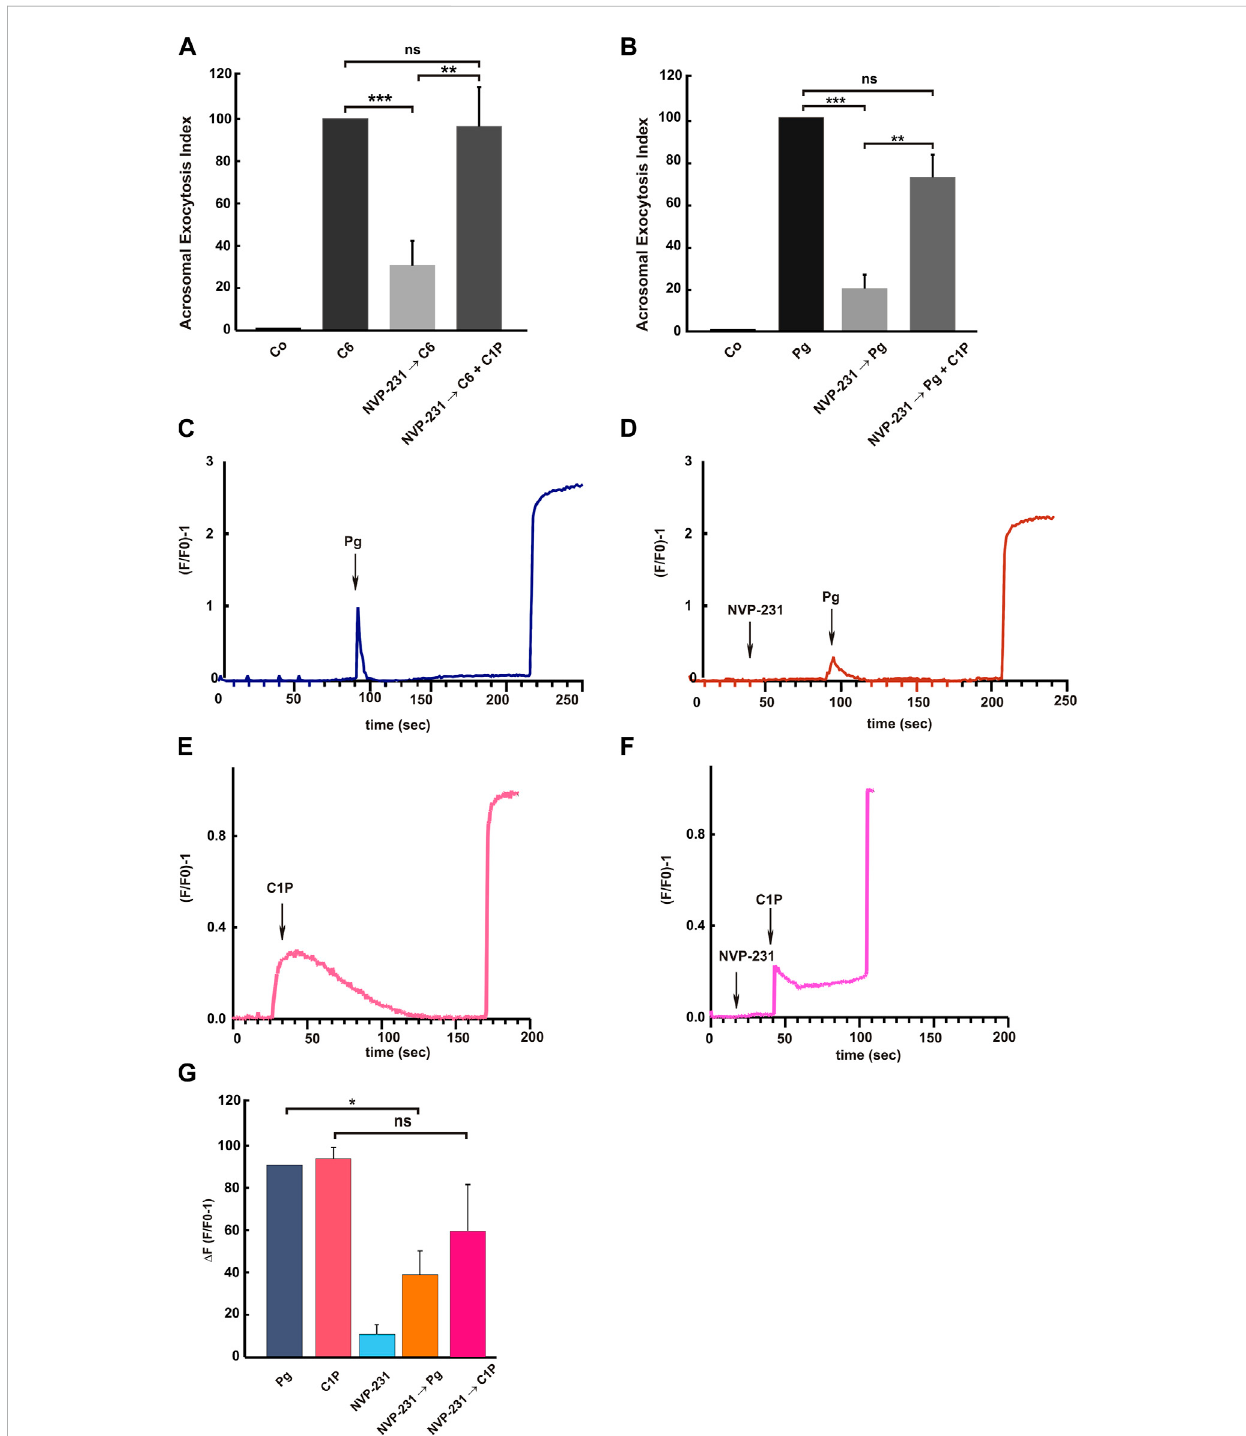
FIGURE 5 Ceramide and Progesterone require C1P to trigger acrosome exocytosis. After swim-up in HTF (5 mg/ml BSA) at 37 ° C, 5% CO 2 , sperm were incubated for an additional 2 h under capacitating conditions. (A) Capacitated sperm were treated with 200 nM NVP-231 for 15 min at 37 ° C in 5% CO 2 and further incubated with 10 μ M C6-Cer (NVP-231 → C6) or with 10 μ M C6-Cer plus 10 μ M C1P (NVP-231 → C6+C1P). C6-Cer (C6) was used as a positive control (B) We incubated capacitated spermatozoa with 200 nM NVP-231 for 15 min at 37 ° C in 5% CO 2 then we treated the cells for an additional 15 min with 15 μ M Pg (NVP-231 → Pg, Pg) or with 15 μ M Pg plus 10 μ M C1P (NVP-231 → Pg + C1P). Sperm were fi xed and acrosomal exocytosis was evaluated by FITC-PSA binding with at least 300 cells per condition scored. Tukey ’ s test was used to compare mean groups of treatments and classi fi ed as non-signi fi cant (ns, p > 0.05) or signi fi cant (**, p < 0.01 or ***, p < 0.001). (C – F) Capacitated human sperm were loaded with 2 μ M Fluo-3 AM for 30 min at 37 ° C. At the indicated times (arrows) 15 μ M Pg was added. Maximal [Ca 2+ ]i response was calibrated with 0.1% Triton X-100 (TX-100) at the end of the incubation period. When indicated, 200 nM NVP-231 was added before Pg or C1P addition. Shown are traces representative of 4 experiments. The increase in fl uorescence is expressed as (F/F0) − 1 ((maximum fl uorescence